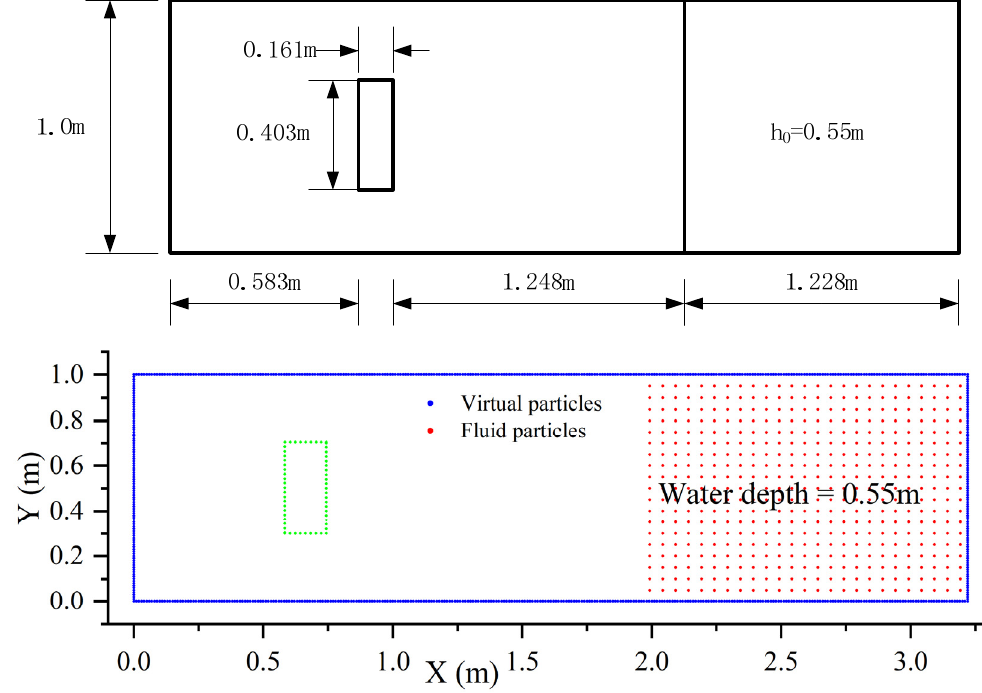
Figure 11. Scheme of the second model used for validation of the new SPH-SWE model proposed [2–83].